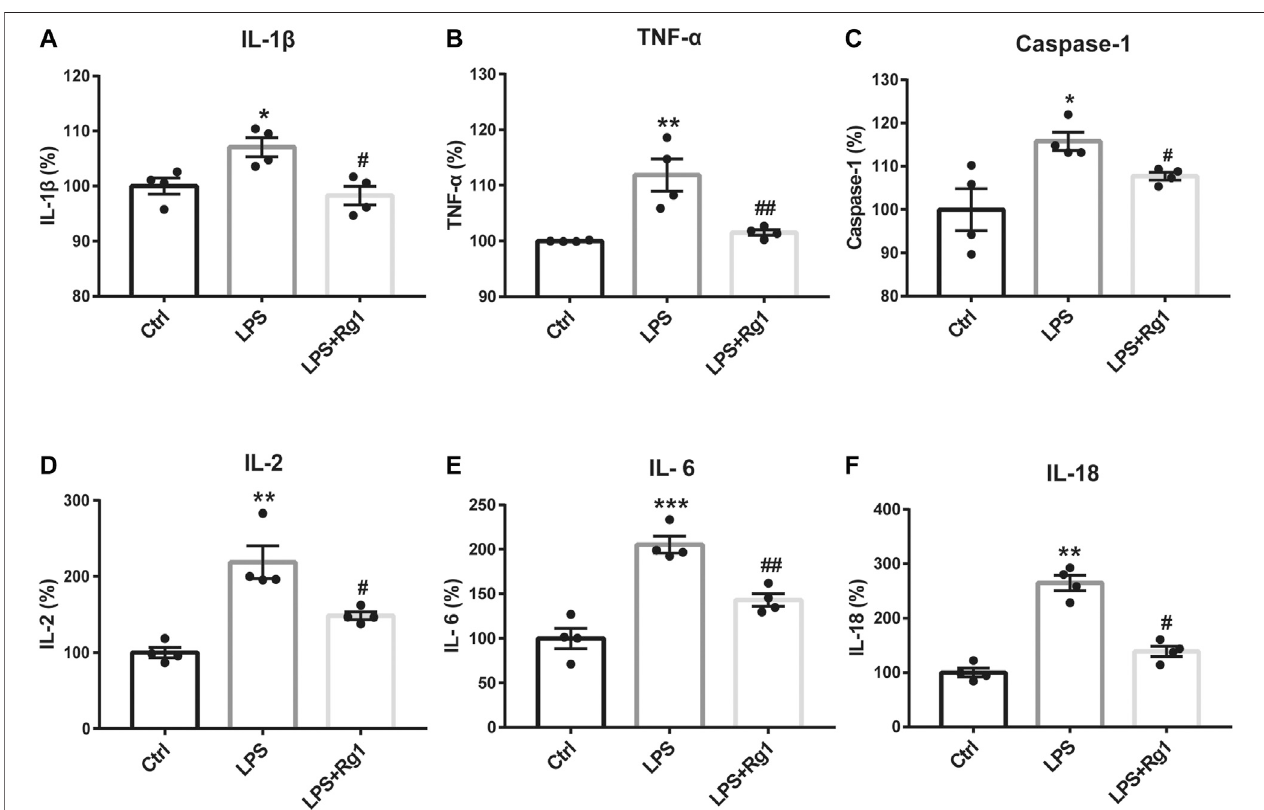
FIGURE6| Rg1suppressesthe increasedpro-in fl ammatorycytokines causedbyLPS inglialcells. Consistent withthe in vivo results, pro-in fl ammatorycytokines, including IL-1 β (A) , TNF- α (B) , caspase-1 (C) , IL-2 (D) , IL-6 (E) , and IL-18 (F) were increased by LPS exposure, which was signi fi cantly suppressed by Rg1 in primary cultured glial cells. n (cid:1) 4. * p < 0.05, ** p < 0.01 and *** p < 0.001, compared with the Ctrl group; # p < 0.05 and ## p < 0.01, compared with the LPS group. LPS, lipopolysaccharide; Ctrl,